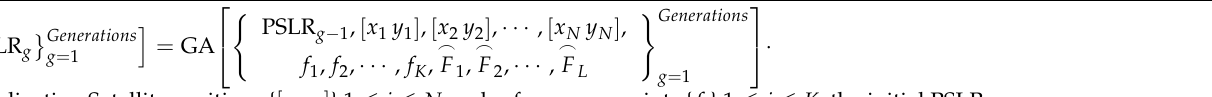
Algorithm 1. The pseudo code with regard to multi-dimensional optimization